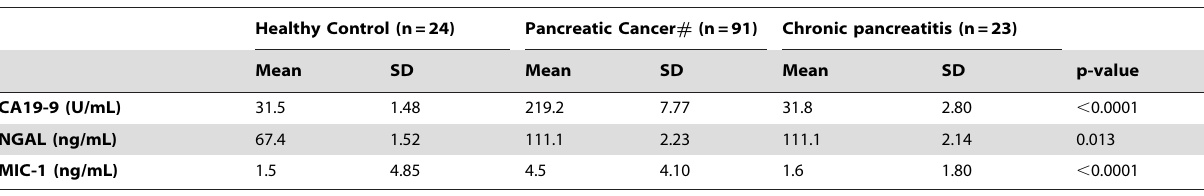
Table 2. Comparison of biomarker levels between patient groups.